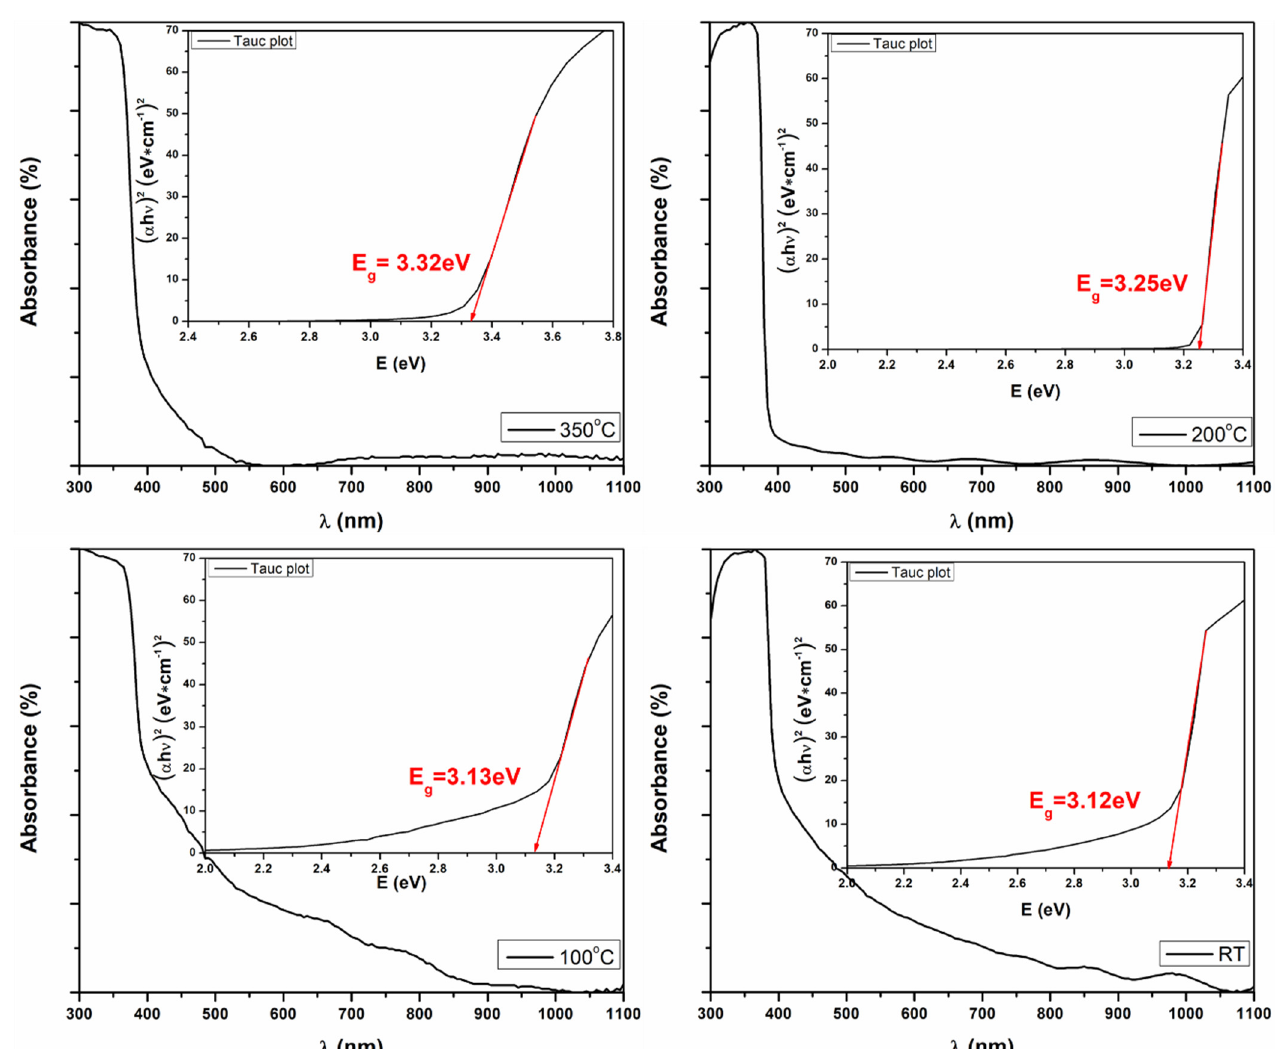
Figure 5. Absorbance spectra of the zinc oxide thin films. Insets show Tauc plots employed for evaluating optical band gap energies of the thin films.